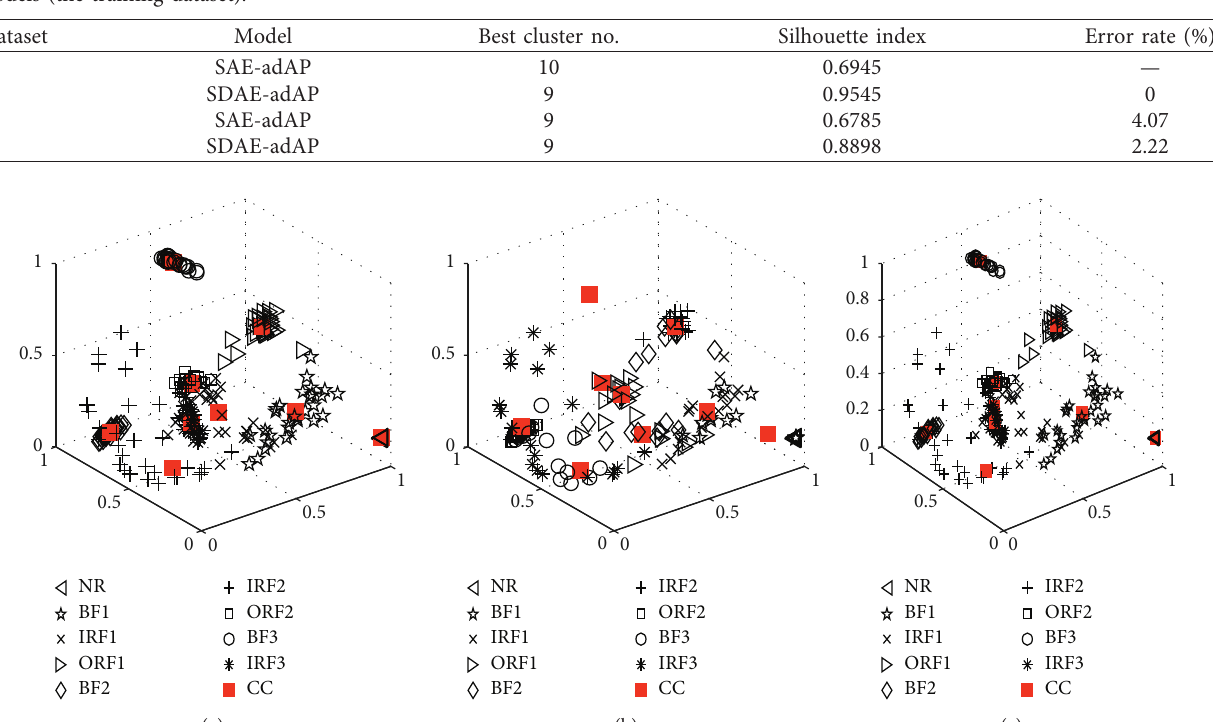
Table 3: The results of the best cluster number and classification error accuracy at the maximum Silhouette index value by using different models (the training dataset).